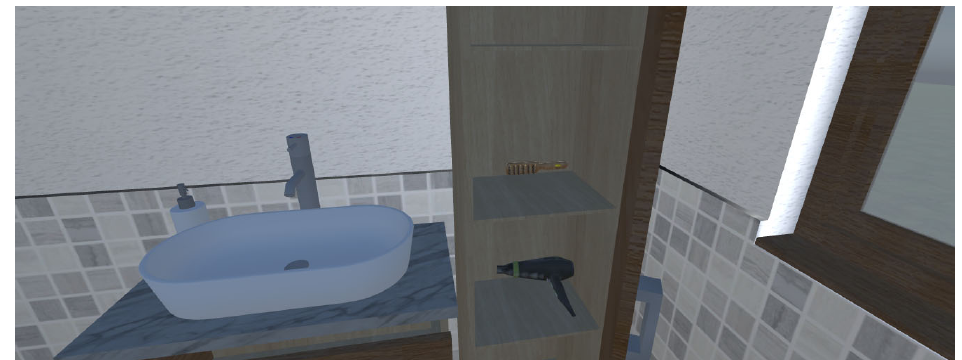
Figure 8. Figure depicting the final step of the fourth exercise. In detail, the final placement of the objects performed by a patient is shown.